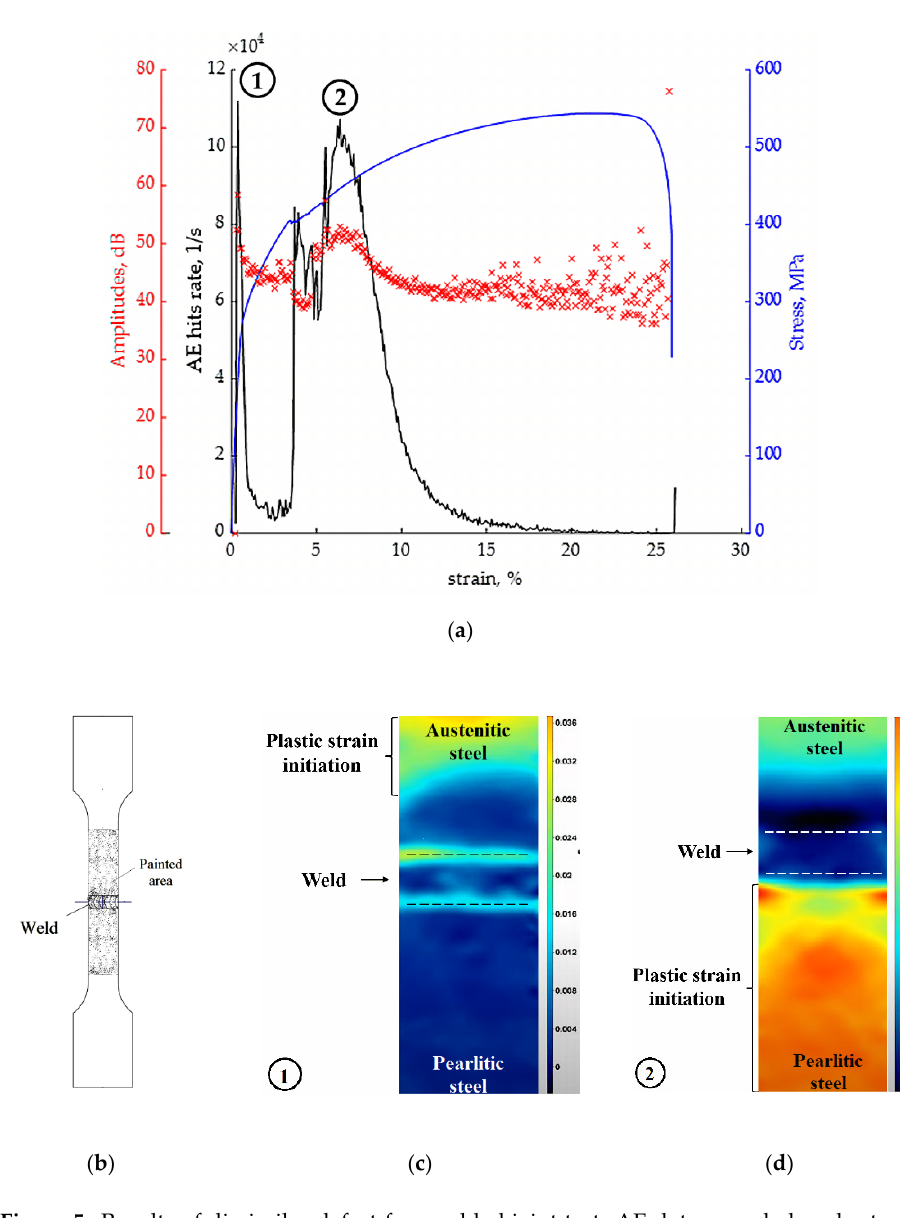
Figure 5. Results of dissimilar defect-free welded joint test: AE data recorded under tension ( a ), sample with a painted area ( b ), and strain distributions over the painted area on different stages of test ( c , d ).